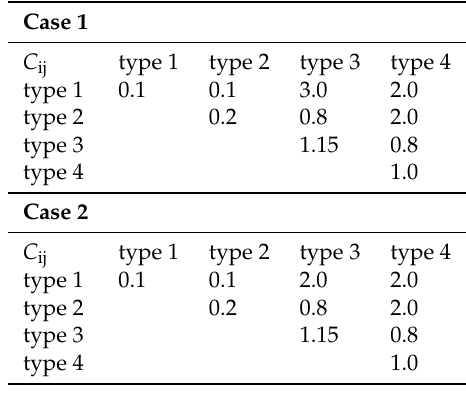
Figure 3. The bead–spring and the MARTINI CG models. ( a ) CG representation of surfactant molecules with T-shape and linear geometry based on the model of Shen et al. [68]. Hydrophobic particles are in red while hydrophilic particles are in blue. ( b ) Aqueous droplet with surfactant based on the MARTINI model; ( c ) Same as in ( b ), but only the surfactant is illustrated; ( d ) A different perspective of the same droplet. Here, a cylindrical droplet is used. Reprinted with permission from Ref. [71]. Table 1. C ij interaction coefficients between different components: type 1 for the hydrophilic head of the surfactant, type 2 for the hydrophobic tail, type 3 for the solvent, and type 4 for the substrate particles